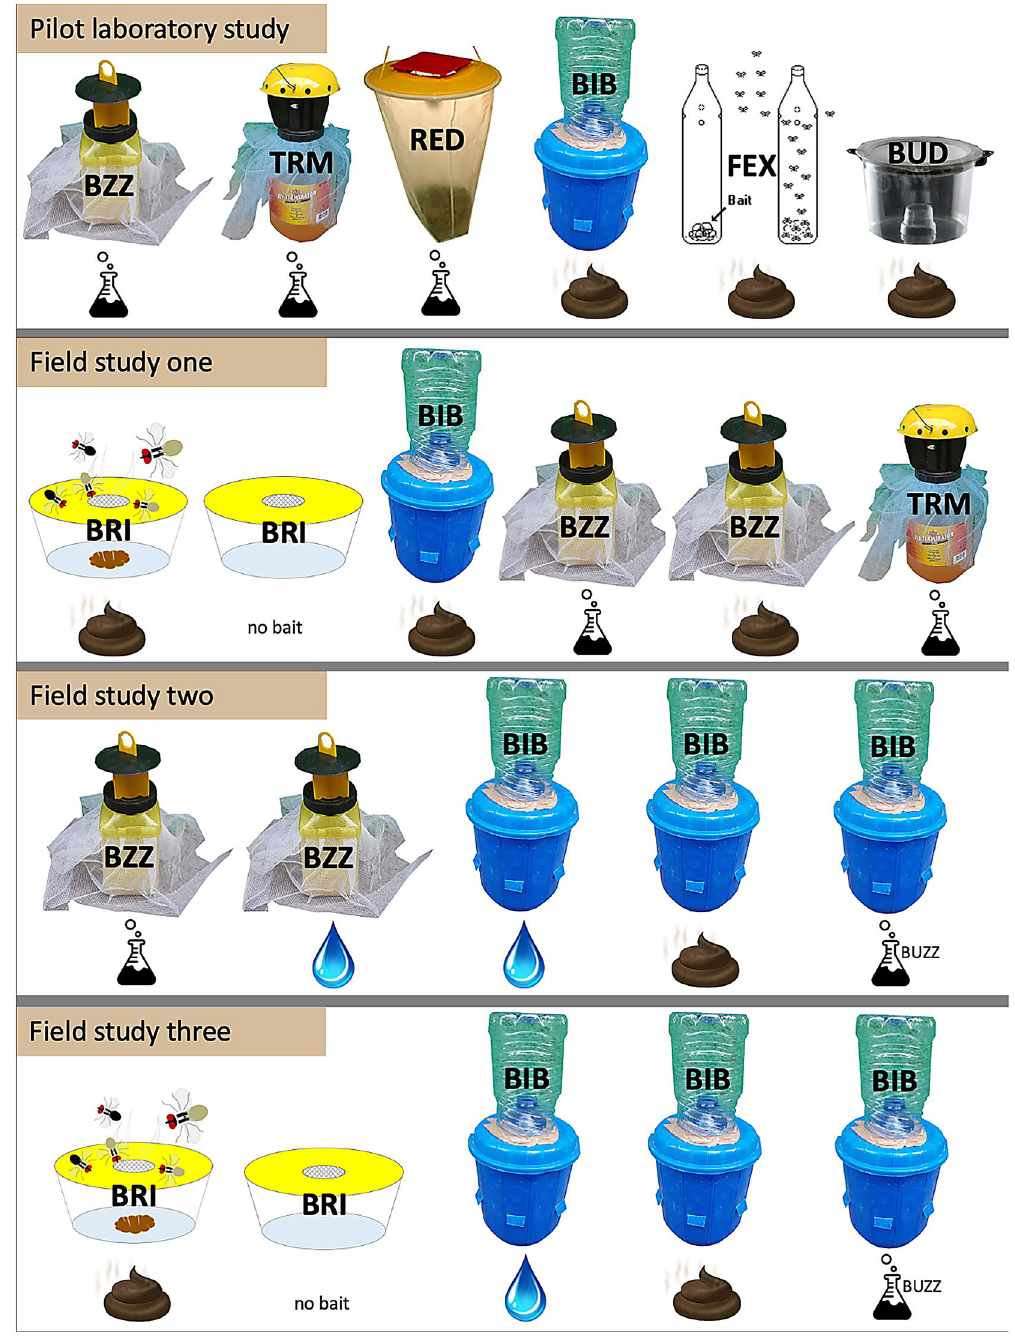
Figure 1. Trap types (design/bait combinations) used in the study. Trap designs are, row one (left to right): The Buzz (BZZ), Terminator (TRM), Red Top (RED), Bickford Bucket (BIB), Field Expedient (FEX), BugDorm (BUD). Row two additionally shows the Bristow trap (BRI, first/second left). Bait types used are shown under each trap design: Erlenmeyer flask (commercial lure of above trap), faeces cartoon (faeces lure), droplet (water lure). Erlenmeyer (BUZZ) indicates The Buzz lure was used with the above